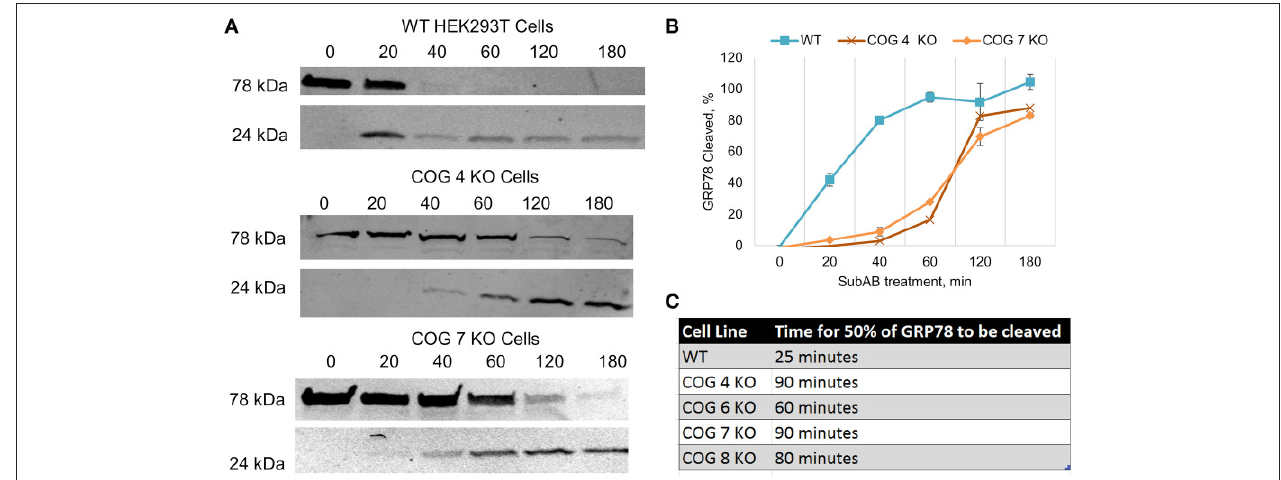
FIGURE 8 | Pro-cathepsin D is secreted from COG subunit KO cells but not WT cells. Cells at 80–100% confluency were placed in chemically defined serum free media. Media was collected at 24 h and then analyzed by western blot for Cathepsin D.